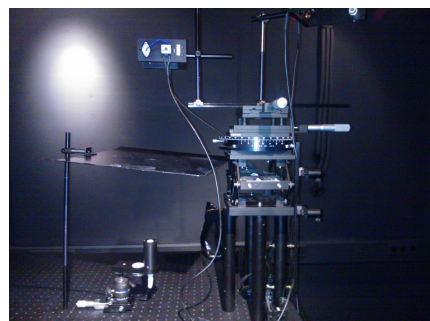
Figure 4. The remote cosine receptor measurement with the ASD FieldSpec Pro JR spectroradiometer.The entrance of the cosine re- ceptor is the small white spot on the top of the black cylinder straight under the lamp. The light spot on the wall is reflection from the laboratory light, which is off during the measurements.